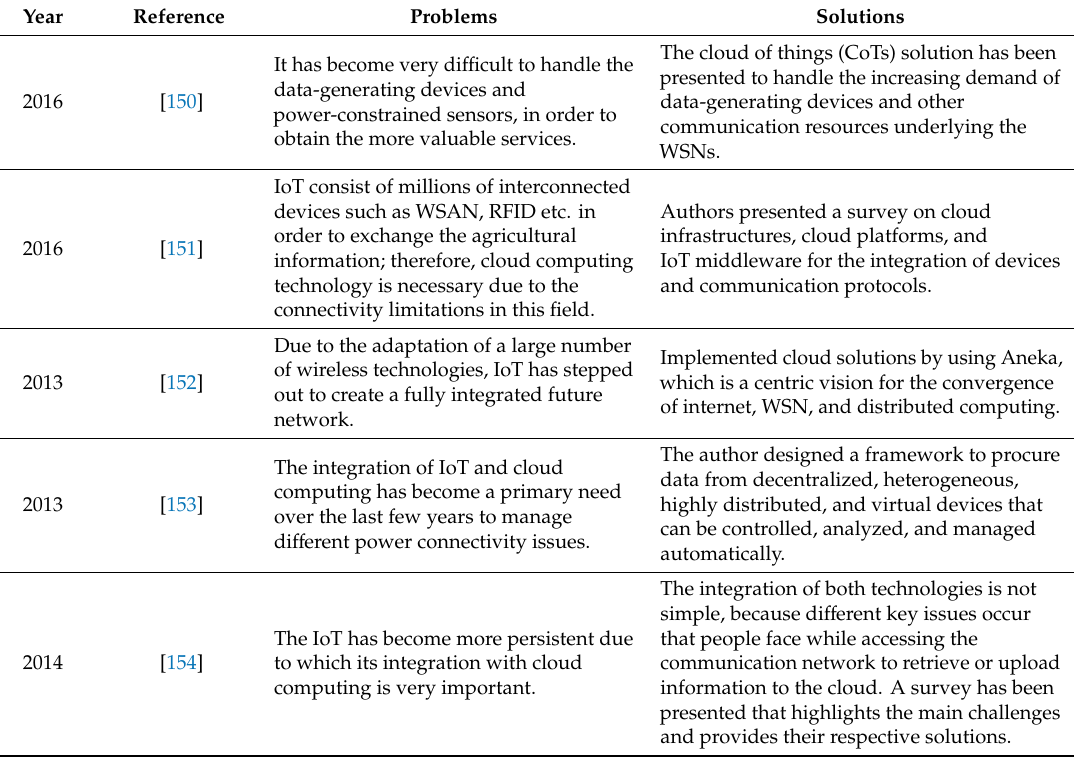
Table 11. Mapping problems and solutions regarding IoT and cloud computing